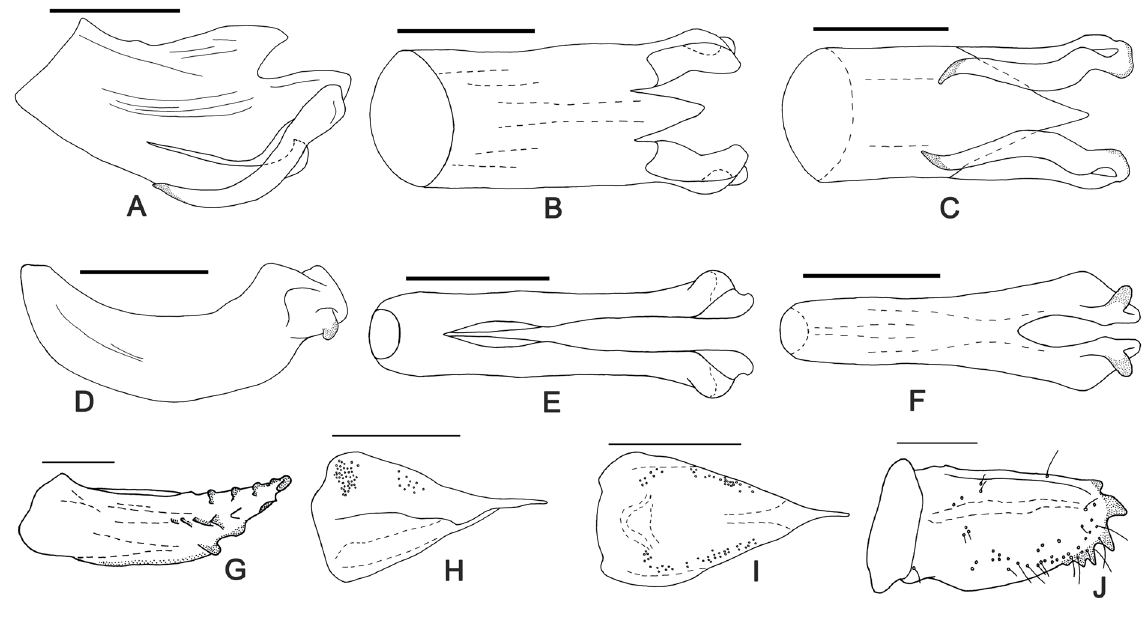
Fig. 4. Atracis patefacta sp. nov. A . Periandrium, right lateral view. B . Periandrium, dorsal view. C . Periandrium, ventral view. D . Aedeagus, right lateral view. E . Aedeagus, dorsal view. F . Aedeagus, ventral view. G . Gonapophysis VIII, right lateral outside view. H . Gonapophysis IX, right lateral